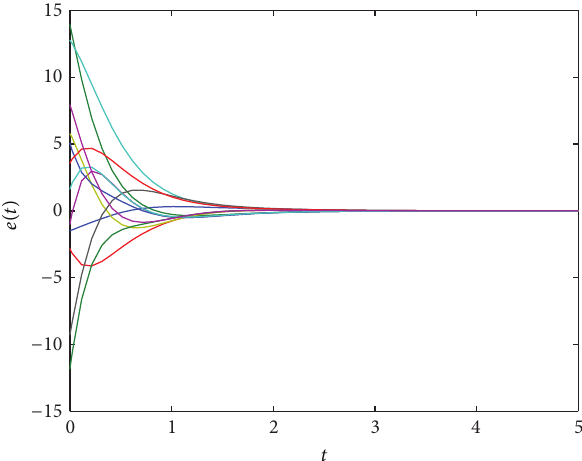
Figure 1: The curve of error 𝑒(𝑡) between the state 𝑥(𝑡) and its estimate ̂𝑥(𝑡) .